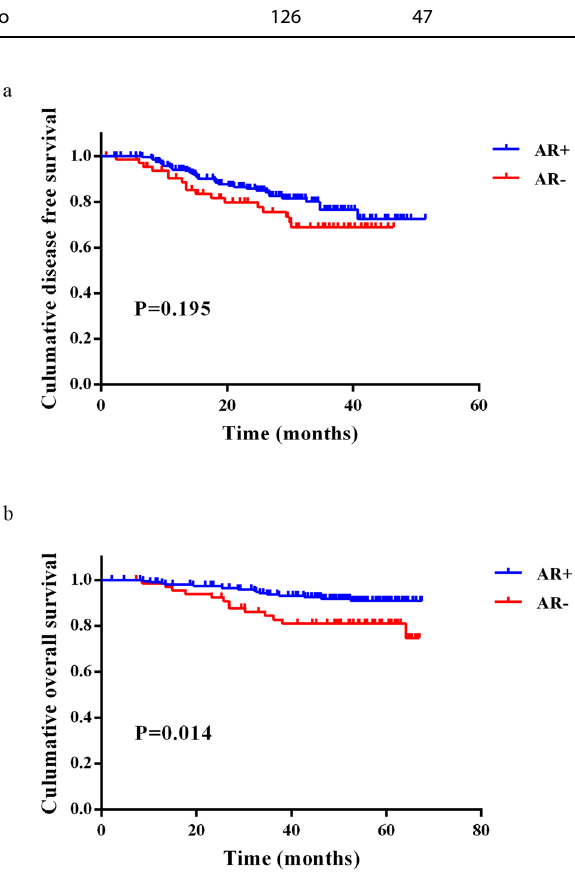
Fig. 3 Survival in patients with HER2 + HR − nonmetastatic IDC according to AR expression (10%). Kaplan – Meier curve for DFS ( a ) and OS ( b ) of HER2 + HR − breast cancer patients strati fi ed by AR status